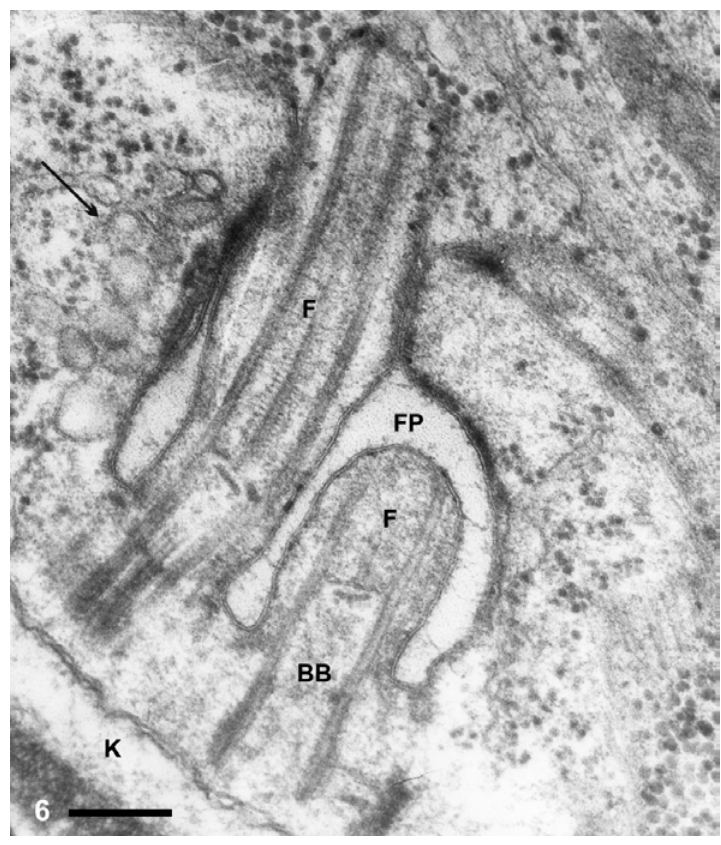
Fig. 6– Anteriorregionofanamastigoteformof Trypanosomacruzi showingtheflagellar pocket (FP), two short flagella (F), the basal body (BB) and the kinetoplast (K). Vesicles are seen close to the flagellar pocket (arrow). Bar, 0 . 25 µ